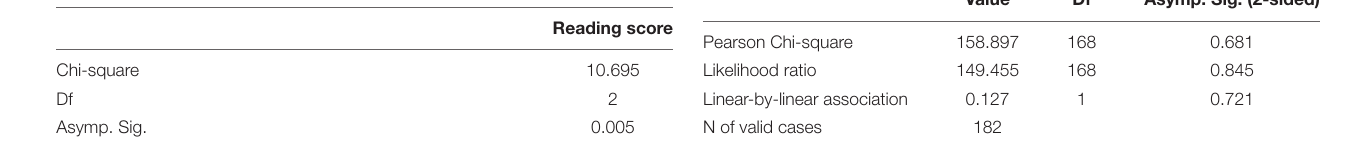
TABLE 2 | Results of the Kruskal–Wallis test.